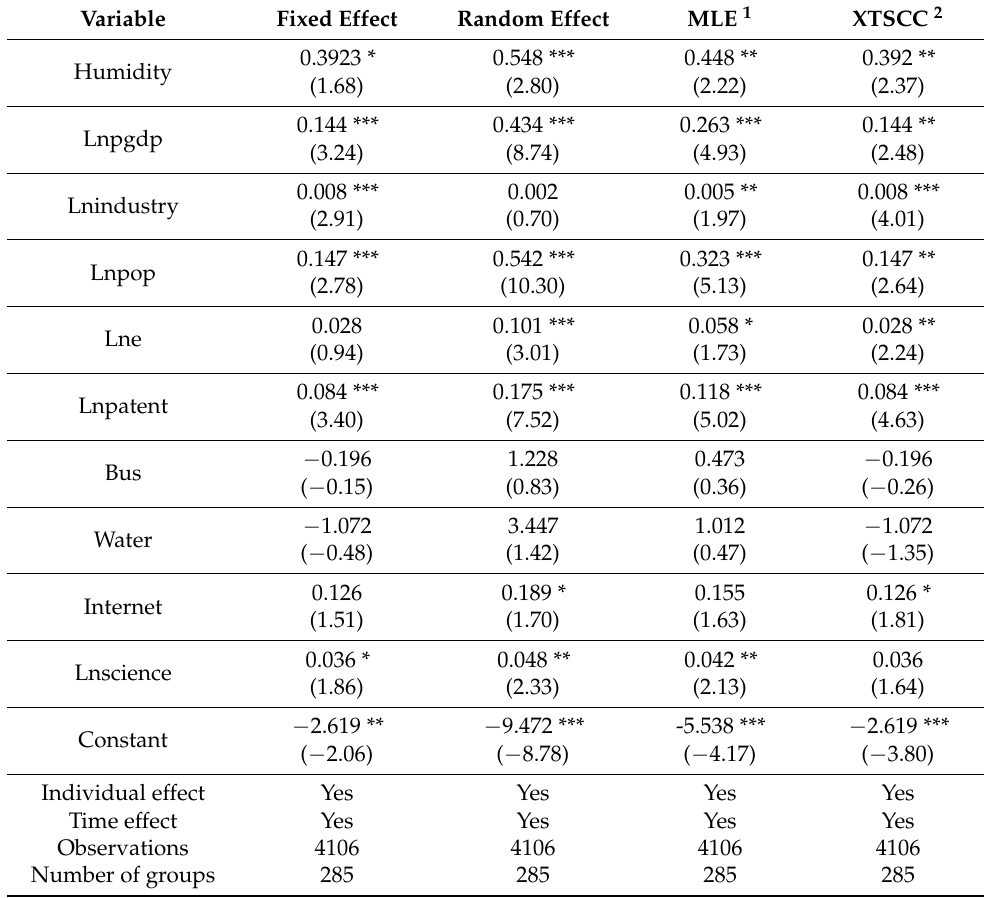
Table A3. Influence of air humidity on location choice of